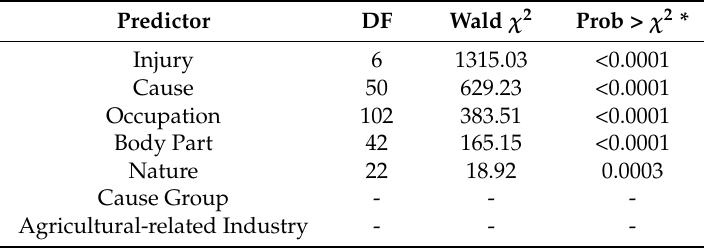
Table 5. Effect test results for the generalized linear model (GLM) with gamma distribution using the lasso penalization method.